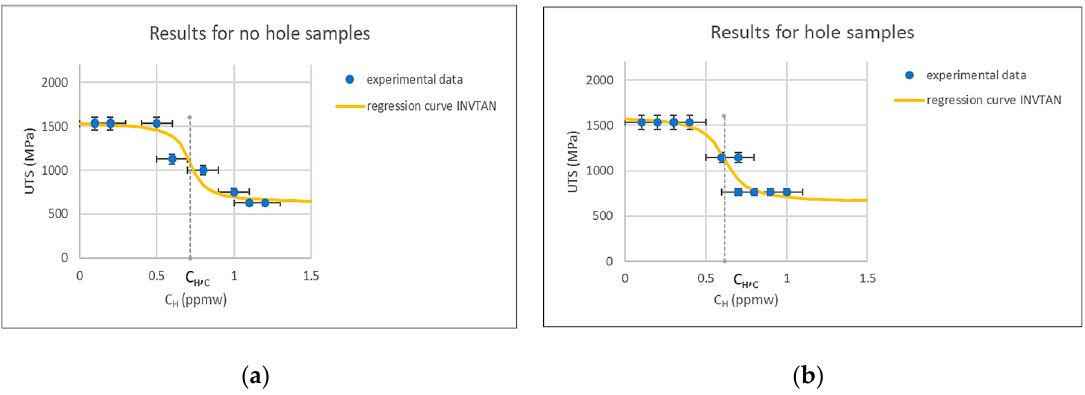
Figure 8. ( a ) USIBOR 1500 ® samples without a hole. ( b ) USIBOR 1500 ® samples with a hole.